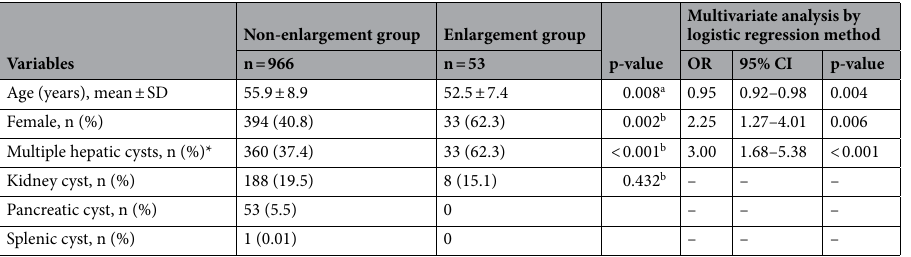
Table 3. Demographic and clinical characteristics in individuals with enlarged hepatic cysts. a Student t test, b Chi-squared test. OR odds ratio, CI confidence interval, SD standard deviation. Cyst enlargement was defined as a transition from ≤ 10 to ≥ 31 mm, or from 11–30 mm to ≥ 51 mm. The non-enlargement group was defined as stable in ≤ 10 mm, a transition from ≤ 10 mm to no cyst, stable in 11–30 mm, and a transition from 11–30 mm to ≤ 10 mm or no cyst. *Number information was missing in 3